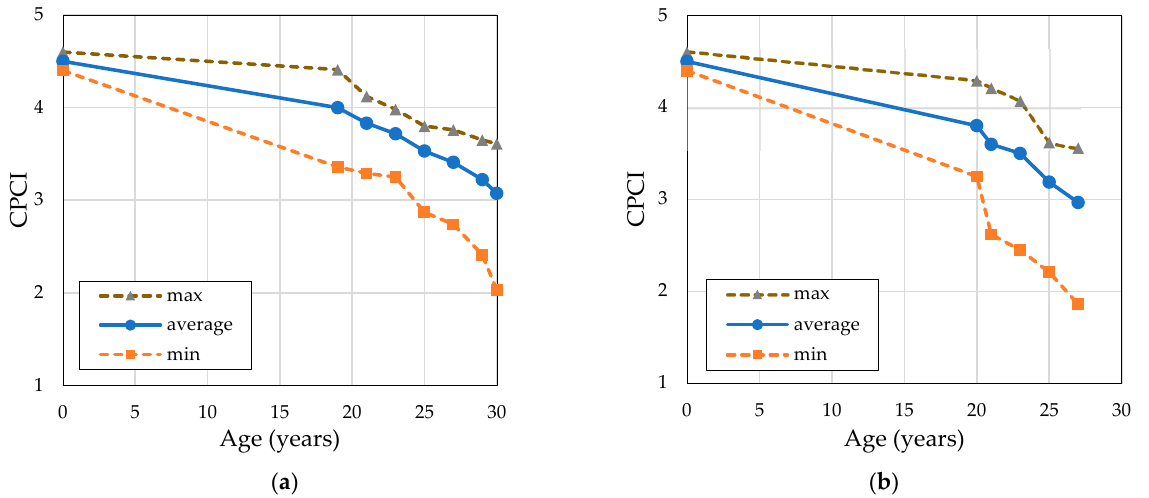
Figure 3. Basic prediction curve by condition history for concrete pavement. ( a ) CPCI prediction, basic model (using 7 points); ( b ) CPCI prediction, basic model (using 5 points).